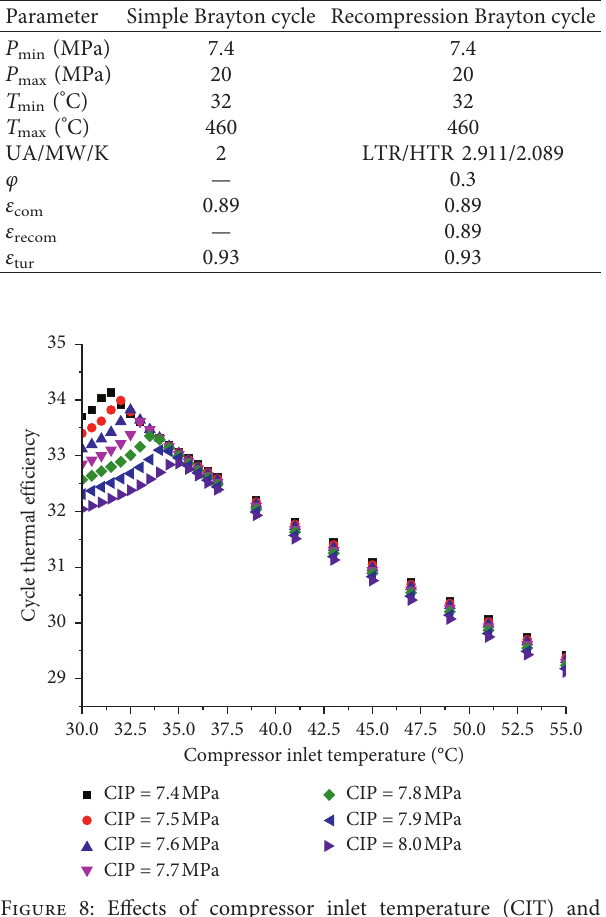
Figure 8: Effects of compressor inlet temperature (CIT) and compressor inlet pressure (CIP) on the cycle thermal efficiency for